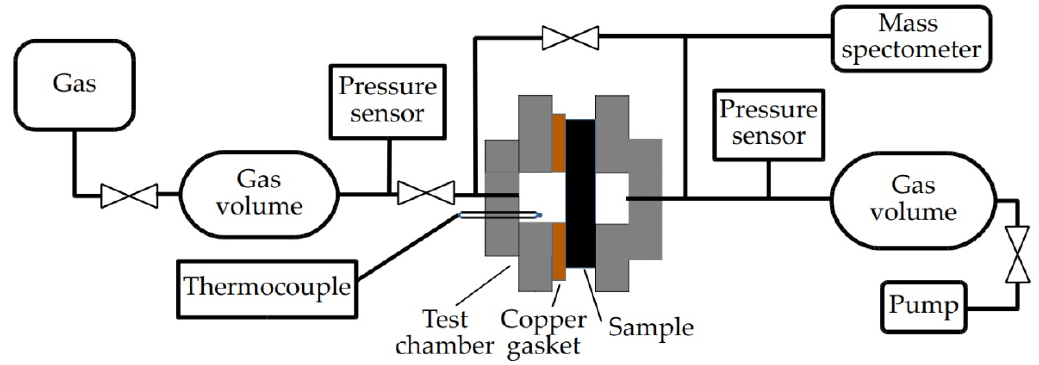
Figure 1. Schematic diagram of the test cell for hydrogen permeation experiments.